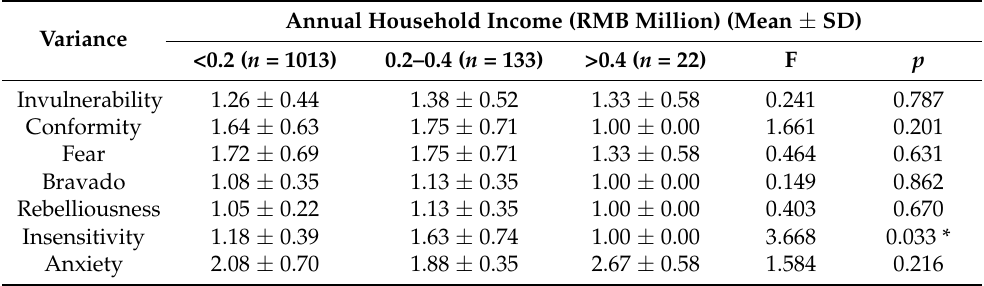
Table 8. The difference in psychological symptoms across the annual household income. Variance